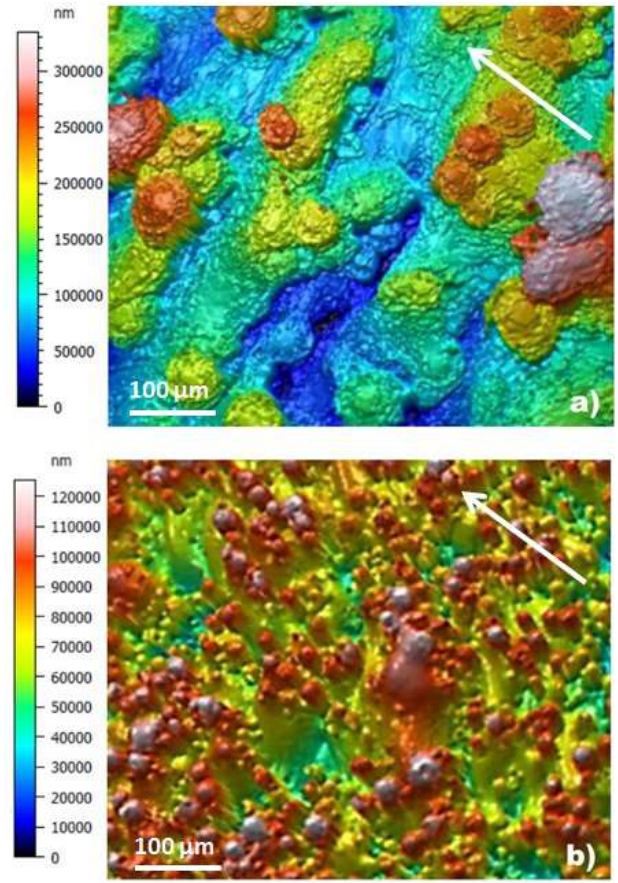
Figure 7. 3D topography of ( a ) as-produced EBM and ( b ) as-produced DMLS specimens (arrows indicate the building direction ).